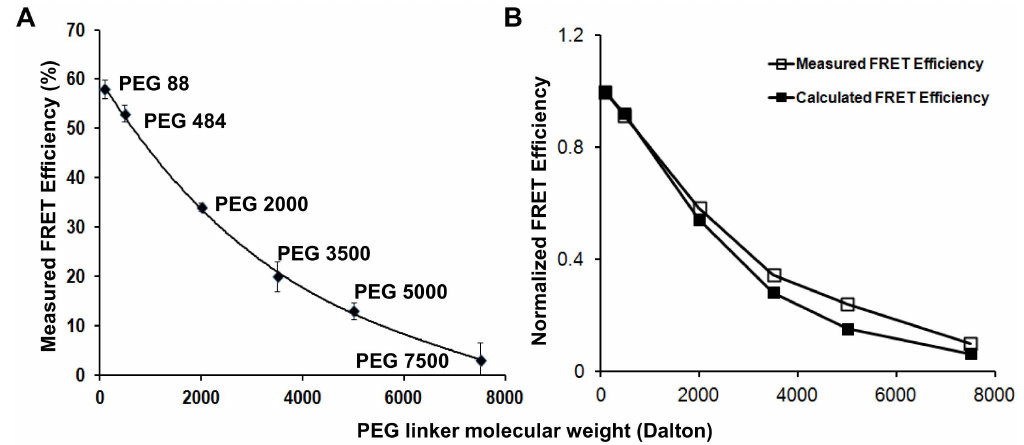
Figure 3. FRET between streptavidin on plastic plates and IEkMCC tethered with PEG polymers. (A) Measured FRET efficiencies of IEkMCC tethered with six different PEG polymers. The intensity of DyLight 549 was captured before and after DyLight 649 was photobleached. The measured FRET efficiency ( E m ) was calculated using the intensity of DyLight 549 before ( Ib ) and after ( Ia ) DyLight 649 photobleaching ( E m ~ The averaged values of two measurements were plotted with standard deviations. (B) After normalization, the measured FRET efficiencies match those calculated based on the Flory radius ( R F ) of the PEG polymers. The R F of the PEG polymer of N subunits and unit length a was calculated using R F ~ a : N 3 = 5 , where a is 0.28 nm [32]. Theoretical FRET efficiency ( E t ) was calculated using the equation E t ~ ( R 0 ) of the DyLight 549-DyLight 649 donor-acceptor pair is 5 nm and the distance between the pMHC ligand and streptavidin r is R F of the PEG polymer plus the pMHC radius of 2 nm. The FRET efficiencies were normalized by dividing the FRET efficiencies by the FRET efficiency of PEG